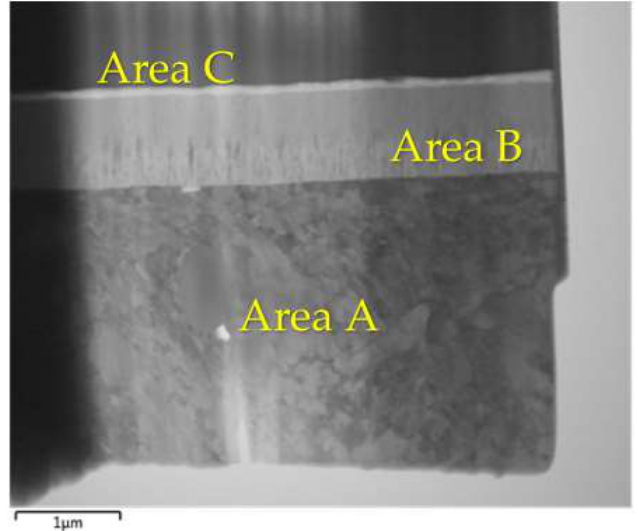
Figure 6. Detail of the top and bottom layers of deposited coating.